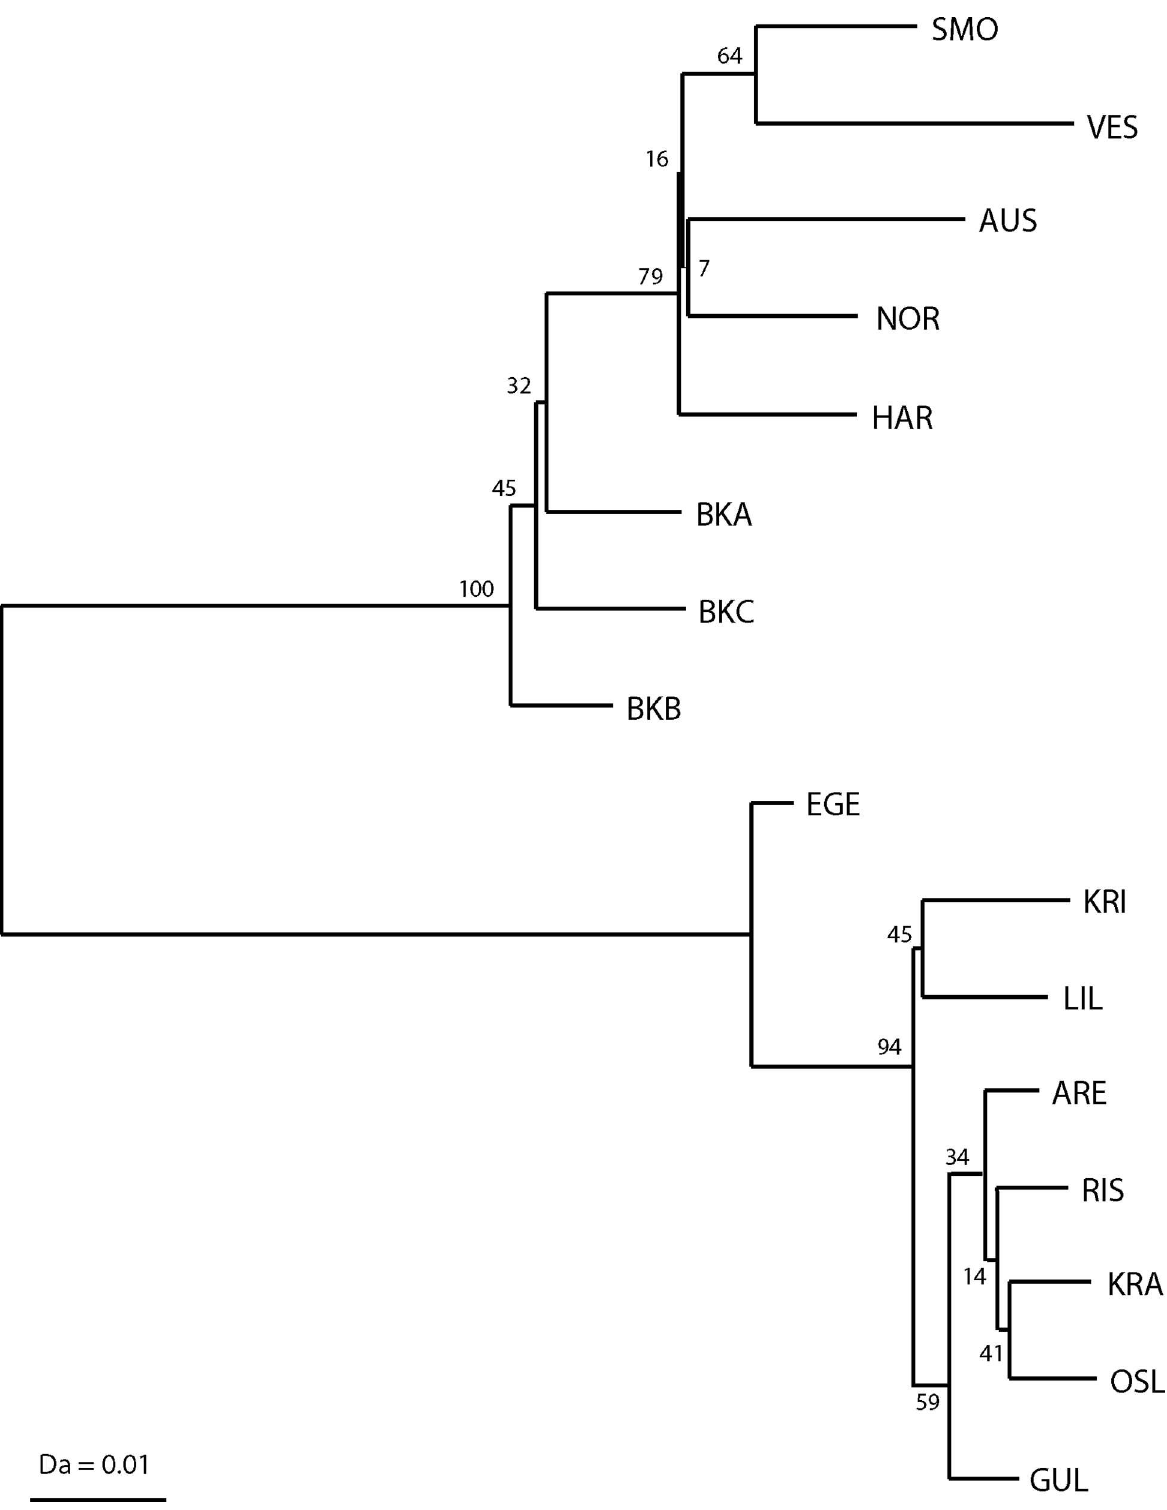
Fig 3. Unrooted neighbourjoiningtree basedon Nei et al .’s [54]Da distances estimatedfor sixteencorkwing wrasse populations at nine microsatelliteloci. Numbersof the nodes indicatethe bootstrapsupport,based on 100 000 replicates.